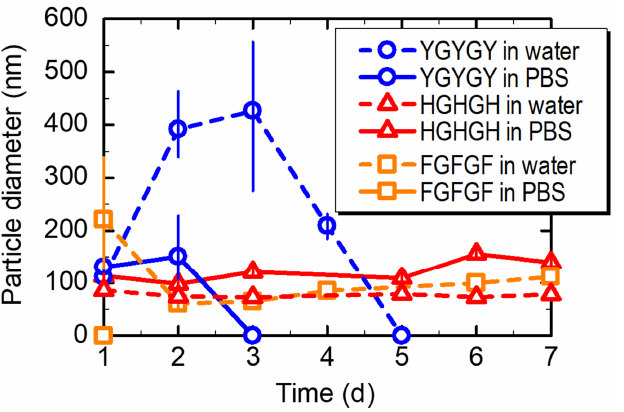
Figure 4. Stability of the YGYGY and HGHGH nanoparticles in water and in phosphoric buffer solution (PBS) simulating in vivo conditions. Table 3. Zeta potential of the produced peptide nanoparticles before and after fluorescent staining.